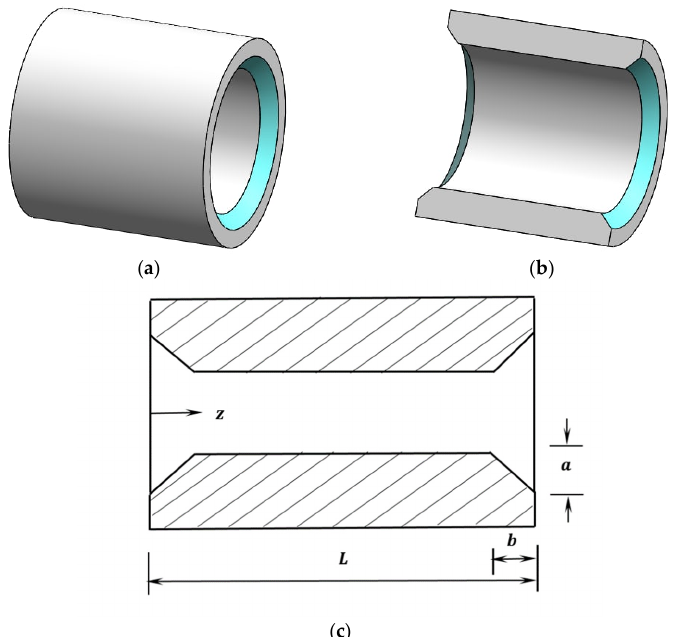
Figure 2. Bearing with modified edges. ( a ) 3D full bearing, ( b ) 3D section and ( c ) Schematic drawing of the bearing after removing material from the inner surface.